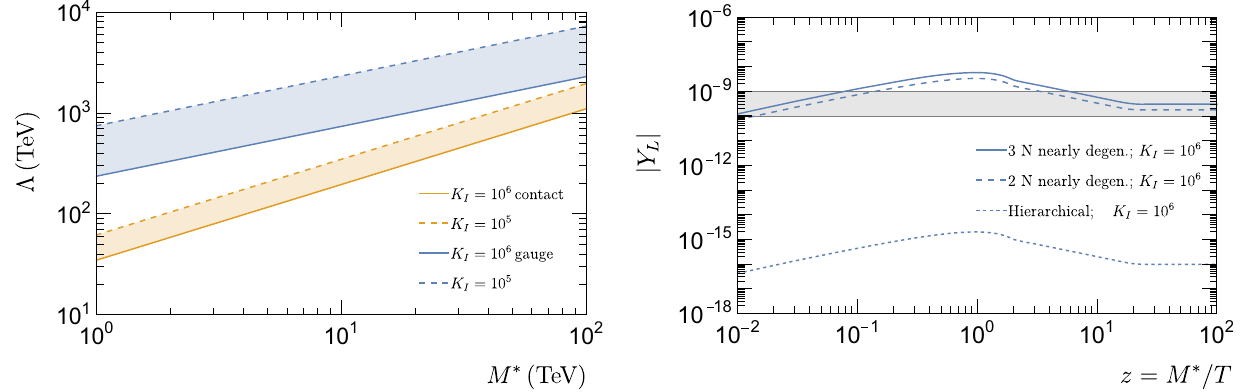
Fig. 7 Left Contour level plots of the wash-out factors in the param- eter space of the model ((cid:3), M ∗ ) for gauge and contact interactions, blue and orange band, respectively. The effective couplings are fixed at | ˜ f | 2 = 10 − 2 = |˜ η | 2 = 10 − 2 . Right lepton asymmetry from Boltz- I I mann equations. The decay parameter is fixed at K = 10 6 and the effective couplings as for the left panel. The solid and dashed blue lines